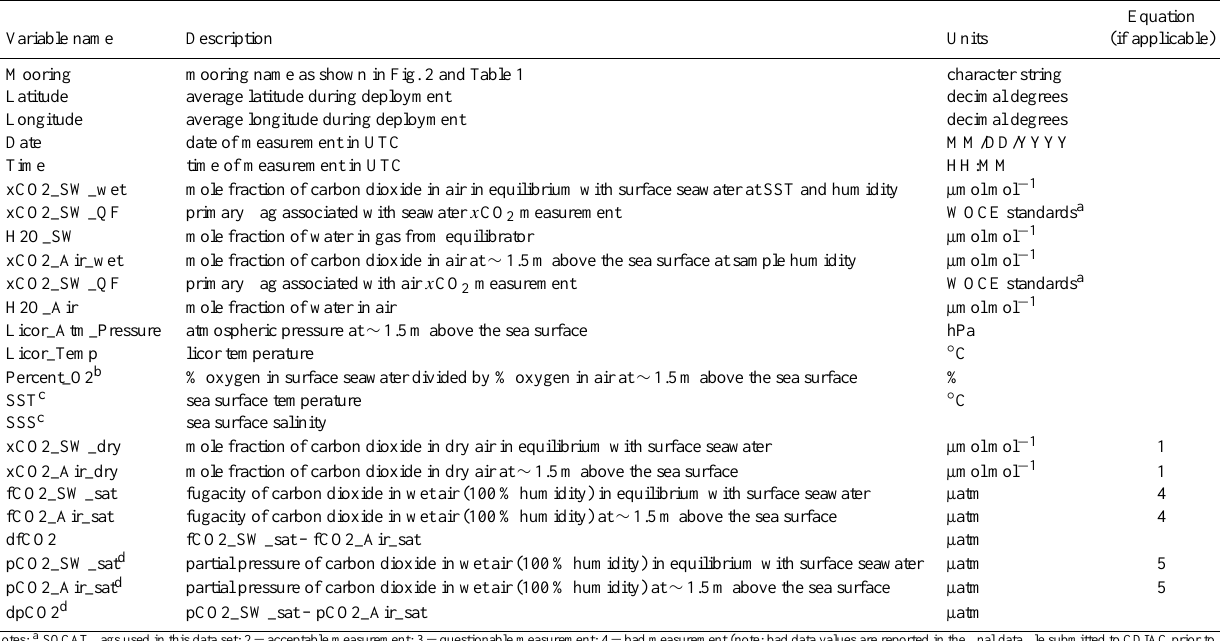
Table 2. Final data variable names and